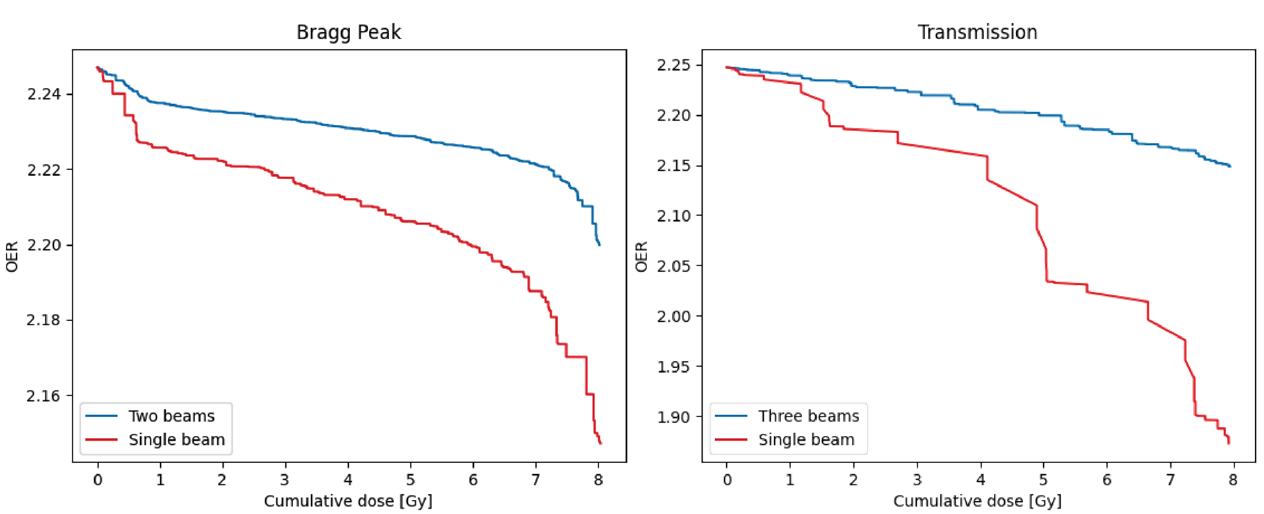
Figure 6. Dose-OER histograms calculated for a single point in the PTV of the Bragg peak ( left ) and transmission ( right ) plans shown in Figure 4, using either the original number of beams (two for the Bragg peak plan, three for the transmission plan), or a single beam from the plan delivering the full 8 Gy dose per fraction. Results were generated for the node 25µm from the